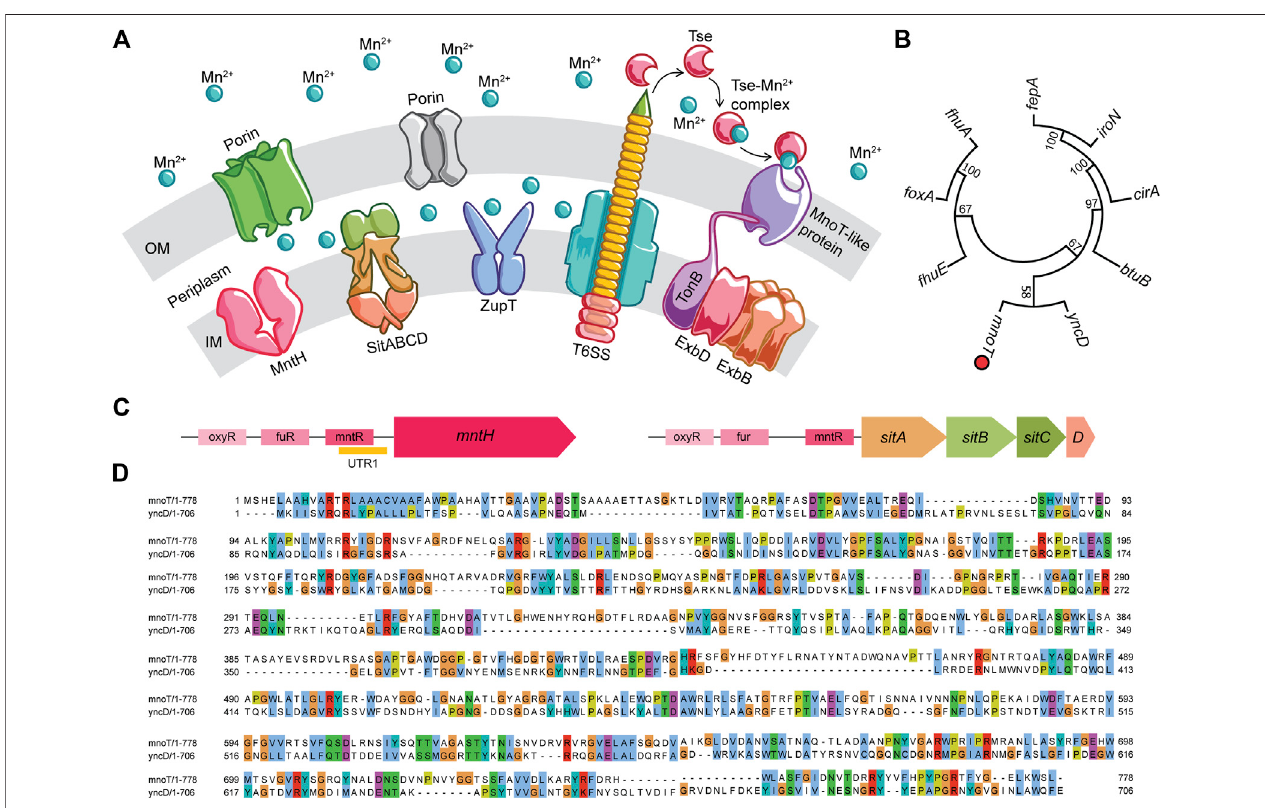
FIGURE 1 | Manganesetransportsystemsin Salmonella . (A) WhiletheoutermembraneispermeabletoMn 2+ ions,theinnermembraneimportsthismetalionviaspeci fi c and non-speci fi c transporters like MntH, SitABCD and ZupT. A type VI secretion system dependent Mn 2+ acquisition mechanism observed in pathogens such as Burkholderia , Vibrio ,and Yersinia isproposed. (B) Neighbor-joiningtreeofMnoT-likeproteinsidenti fi edin Salmonella genomebyPatternHitInitiatedBLAST. (C) Geneticorganizationof mnTH and sitABCD operonswithregulatoryelementsinthepromoterregions. (D) Clustalalignmentof Burkholderia MnoT(WP_171466016)and Salmonella YncD(ACY88391.1) proteinsbyClustalOmegaaligner.ThealignmentresultswereextractedandreformattedinMViewcommandlineutility.Allproteinidentitieswerenormalizedbyalignedlengthand the residues are colored using the default built-in colormap.